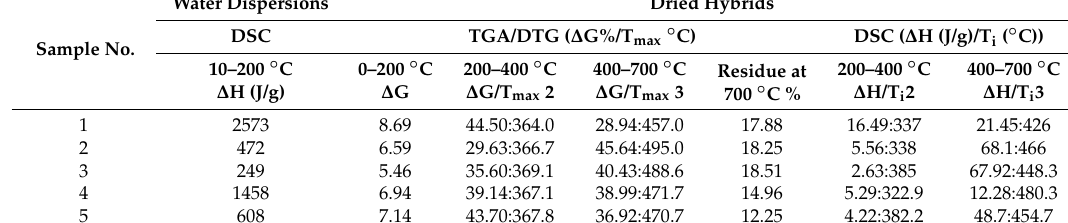
Table 2. Thermogravimetry (TG) and differential scanning calorimetry (DSC) (TG-DSC) coupled analysis results for the octadecyl-modified silica hybrids. Sample No.